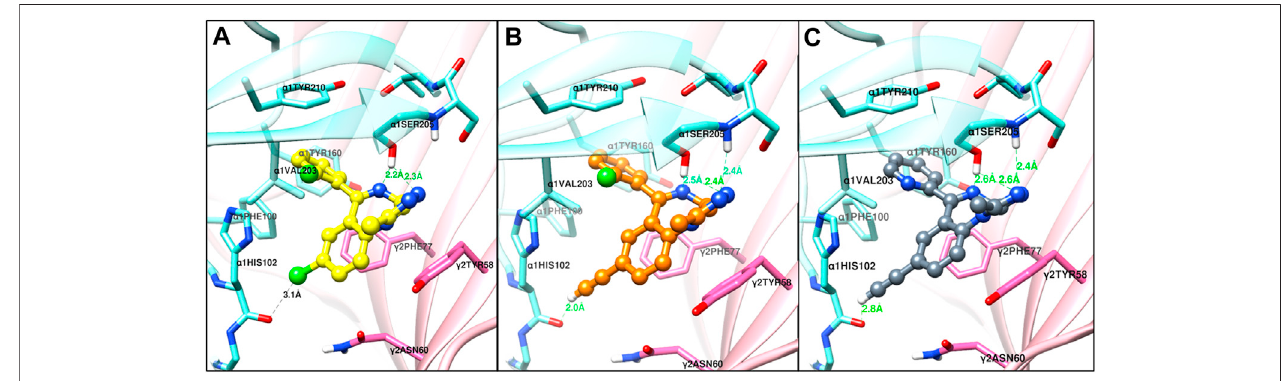
FIGURE7 | The docked con fi rmations oftriazolam (yellow), XLi-JY-DMH (orange) and SH-TRI-108 (gray) in the complex with the α 1 β 3 γ 2L GABA A receptor 6HUO at the α + γ − interface benzodiazepine binding site [ α 1 (aquamarine) and γ 2 (orchid)], dashed lines indicate hydrogen bonds (green) and halogen bond (black).